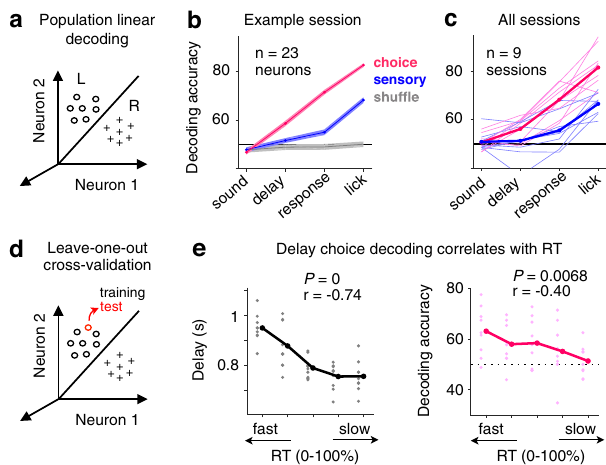
Fig. 4 Linear classi fi cation of population activity predicts animal ’ s choice and RT. a Schematic to illustrate the linear decoding method using population activity. Clouds of hypothetical population responses corresponding to different conditions (left or right choices) are linearly discriminated in high dimensional neural activity space. b Classi fi cation accuracy of decoders trained on 23 simultaneously recorded neurons from one example session. Choice decoding corresponds to classi fi cation between left versus right choices; sensory decoding corresponds to classi fi cation between high versus low click rate trials; gray lines show performance on data with shuf fl ed trial labels. Mean ± s.e.m. across 100 cross-validated samples. c Decoding accuracy for all sessions ( n = 9), similar to b . Thin lines, individual sessions; thick lines, mean across sessions. d Schematic to illustrate leave-one-out cross-validation. e Left, delay durations binned over each 20 percentile of response times (RT) across sessions ( n = 9). Gray dots, individual sessions; black dots, mean across sessions. Right, delay activity choice decoding accuracy binned over each 20 percentile of RT. Light pink dots, individual sessions; Dark pink dots, mean across sessions. r, Pearson ’ s correlation coef fi cient, P values report the signi fi cance of t